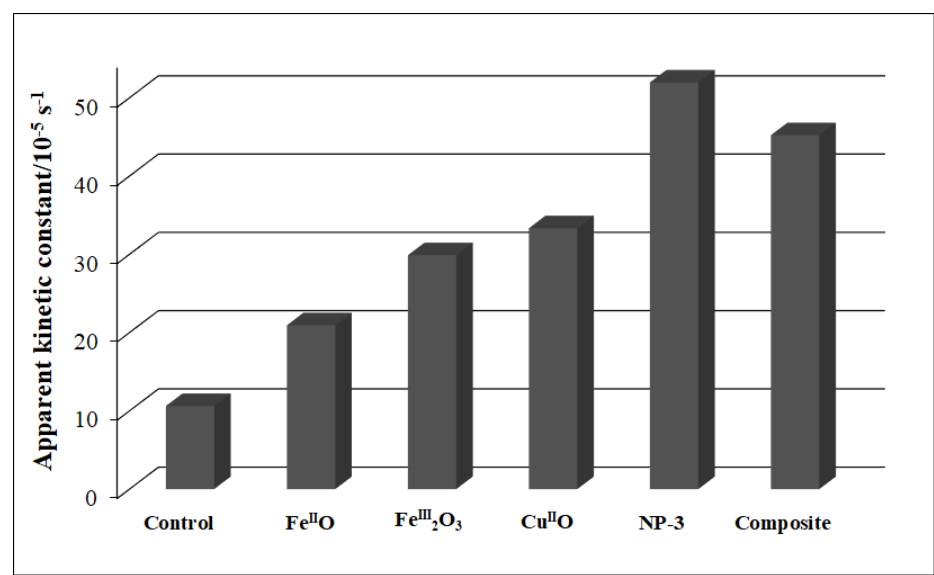
Figure 7. Comparison of apparent kinetic constants of Fe II O, Fe III2 O 3 , Cu II O, NP-3 (Cu II 0.4 Fe II 0.6 Fe III 2 O 4 ), and Cu II O/Fe II O/Fe III2 O 3 composite. Experimental conditions: concentration of NPs = 400 mg/L, concentration of MB = 1.5 × 10 −5 mol/L, concentration of H 2 O 2 = 1.76 × 10 −1 mol/L, and initial pH = 7.5.